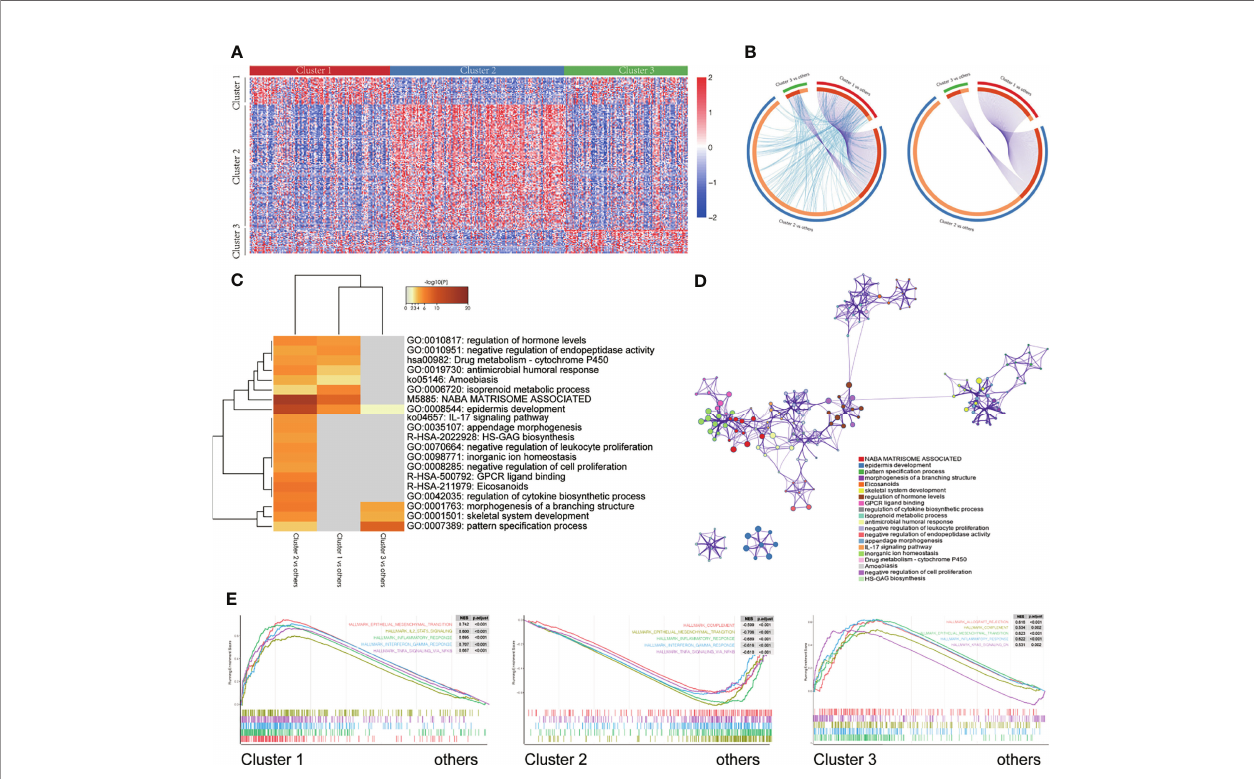
FIGURE 5 | Enrichment of different gene signaling pathways in different m 6 A modi fi cation patterns. (A) Heatmap showing the expression of different genes in three different m 6 A modi fi cation patterns. (B) Circos diagram showing the overlap of differentially expressed genes by pairwise comparison of three different m 6 A modi fi cation patterns. Each arc in the outer circle represents the comparison group, and each arc in the inner circle represents a gene list. Each gene has a point on the arc. Dark orange represents the genes that appear in multiple lists, and light orange represents the only gene in the list. The purple line indicates the overlap between genes. The more purple links and the longer the dark orange arc, the higher the overlap between input gene lists, where they fall into the same ontology term (the term has to be statistically signi fi cantly enriched and with a size no larger than 100). (C) The thermogram shows the enrichment of gene signaling pathways with different m 6 A modi fi cation patterns. The heat map cells are colored by their p-values, and the white cells indicate that the term lacks enrichment in the corresponding gene list. (D) Selected representative signal paths shown in a network layout. Each signal path is represented by a circular node, whose size is directly proportional to the number of input genes in the term. The color represents the cluster identity, i.e., nodes with the same color belong to the same cluster. Terms with similarity score > 0.3 are linked by edges (the thickness of the edge represents the similarity score). The network was visualized using Cytoscape (v3.1.2). (E) GSEA of the marker gene set downloaded from the MSigDB database. All transcripts were sequenced according to the multiple variations (log 2 ) obtained using the different analyses among three different m 6 A modi fi cation patterns. GSEA analysis evaluated the skewness of the two distributions of the selected gene set in the sequenced gene